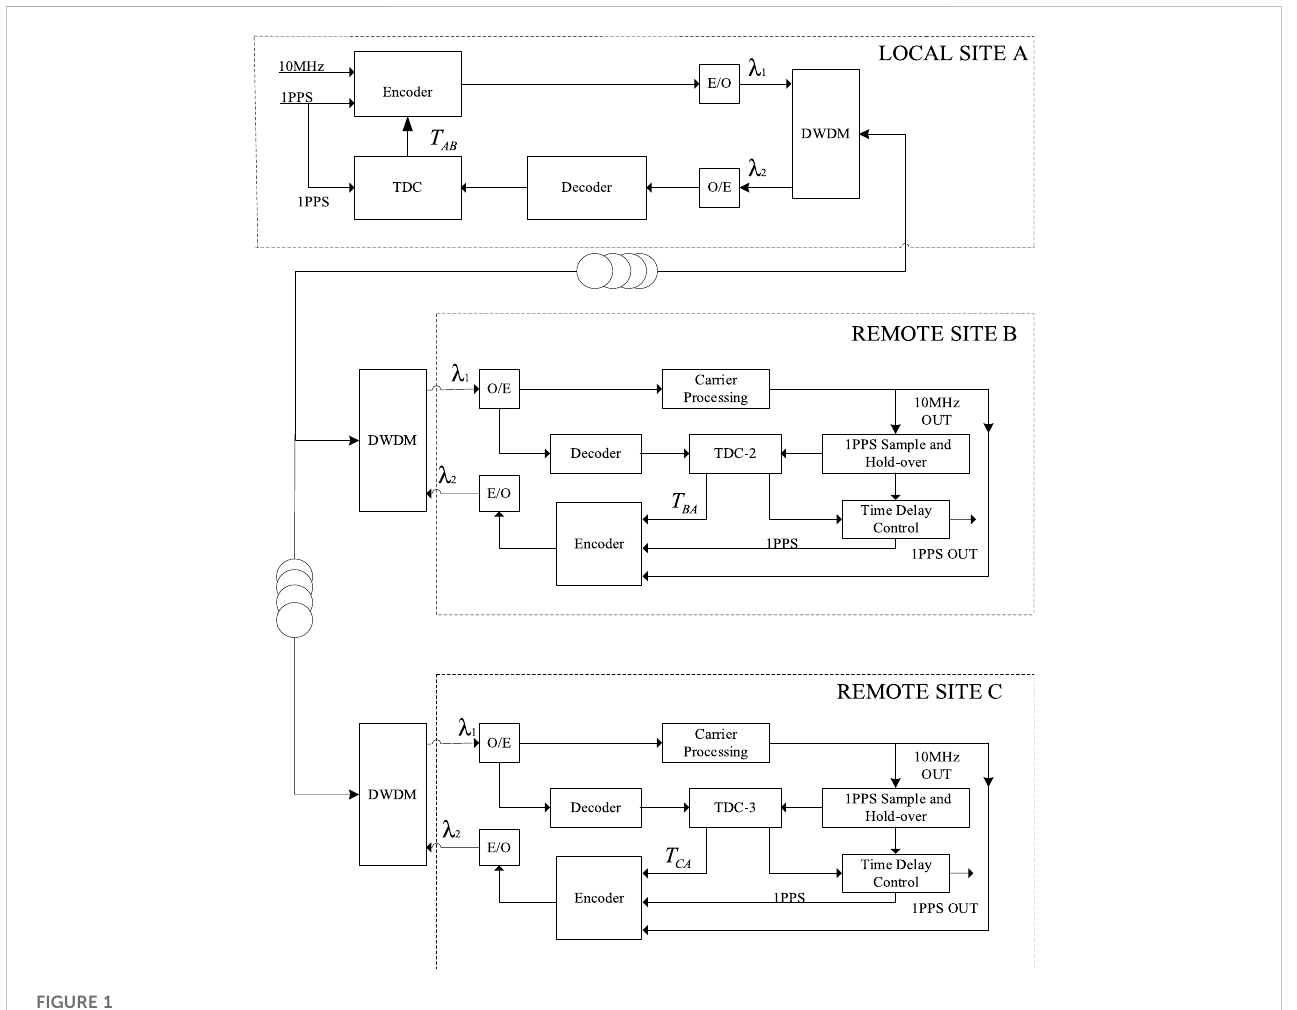
FIGURE 1 Schematic diagram of the SFWDM-TDM